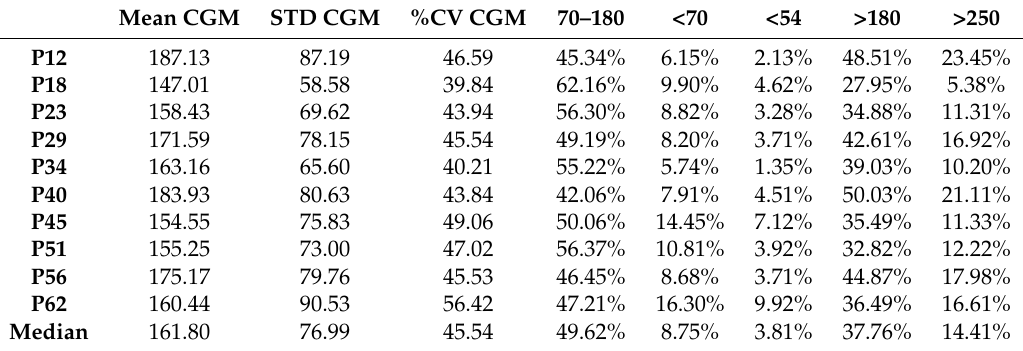
Table 1. Summaryof continuous glucose monitoring (CGM) data (mg/dl) from each